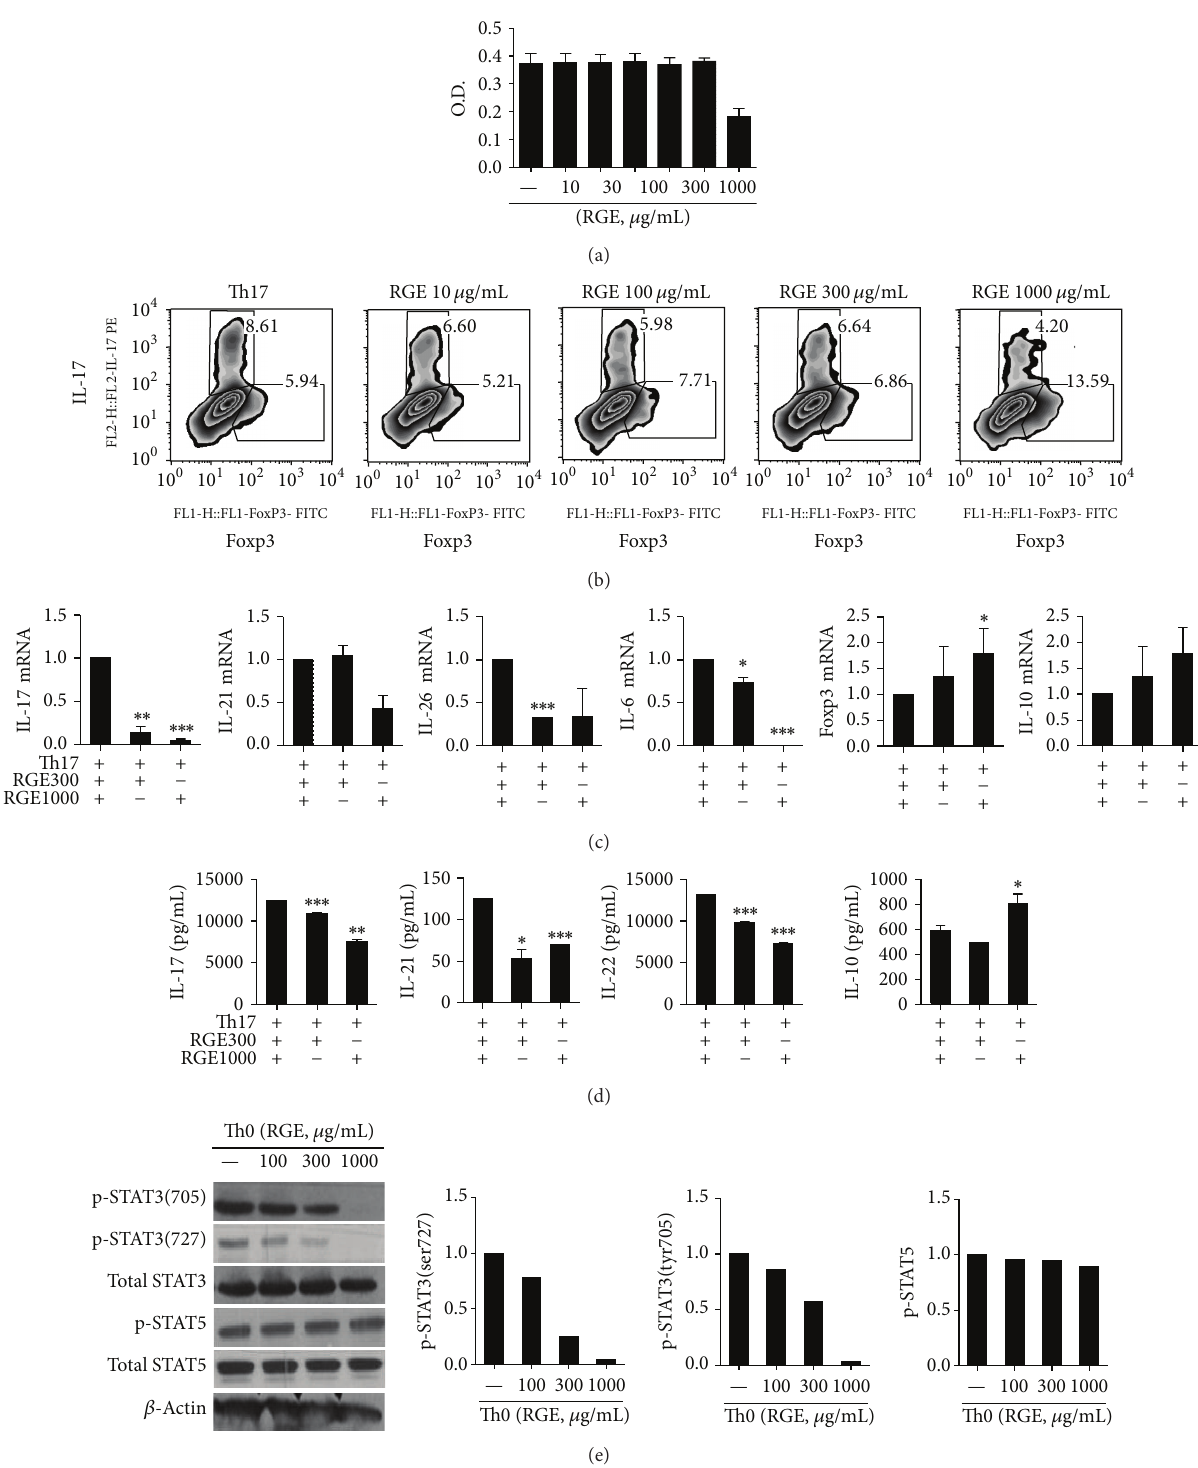
Figure 5: Red ginseng extract increased Foxp3-expressing regulatory T cells and decreased IL-17-expressing Th17 cells in human PBMCs. CD4 + T cells were isolated from human peripheral blood and cultured with various concentrations of red ginseng extract (RGE) (a) MTT assay (b) The proportion of IL-17 positive cells and Foxp3 positive cells was analyzed by flow cytometry. (c) The mRNA expressions of Th17 - and Treg-associated molecules were measured by RT-PCR. (d) The concentrations of IL-17, IL-21, and IL-22 in the supernatant were measured by ELISA. (e) The level of total and phosphorylated STAT3 (at Y705 and S727, resp.) and STAT5 was assessed by western blotting. Data are presented as the mean ± SD of three independent experiments ∗ 𝑃 < 0.05 , ∗∗ 𝑃 < 0.01 , and ∗∗∗ 𝑃 < 0.001 compared to